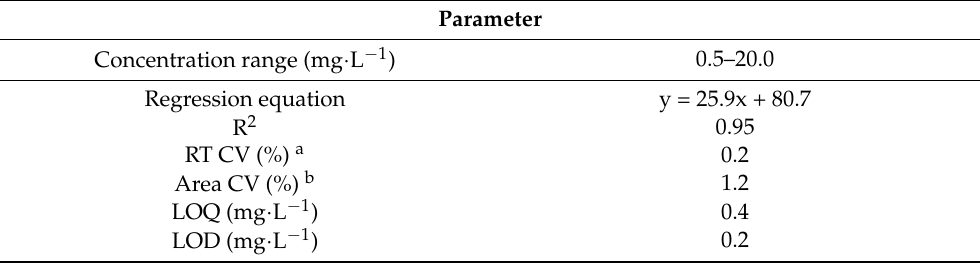
Table 1. Parameters for quantification of